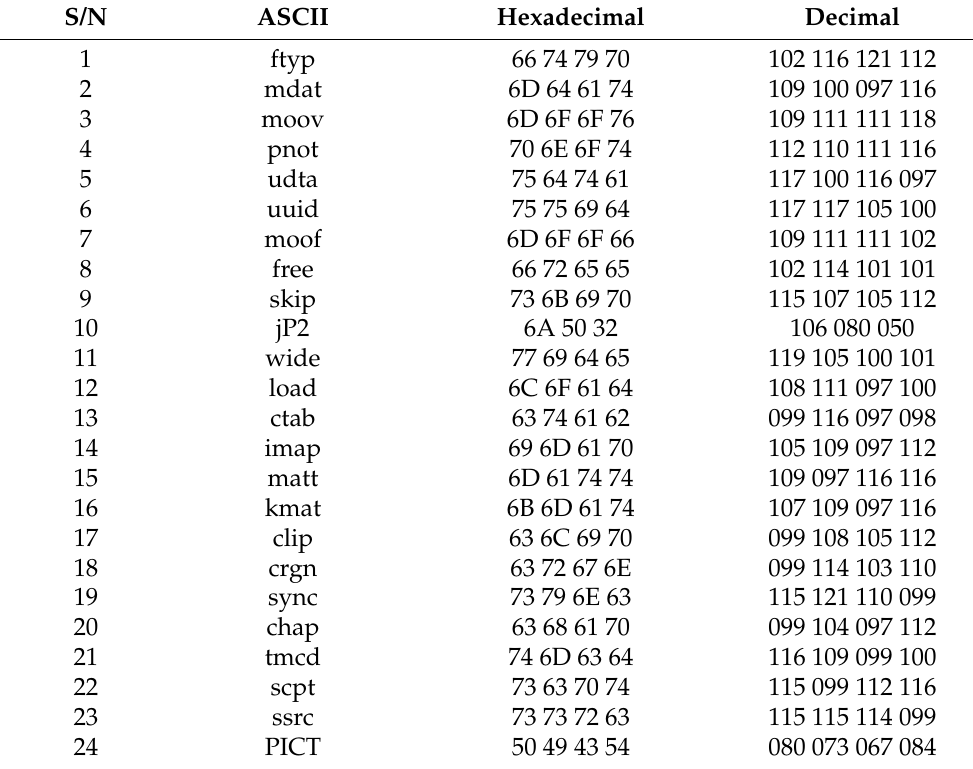
Table 3. MP4 signature types.